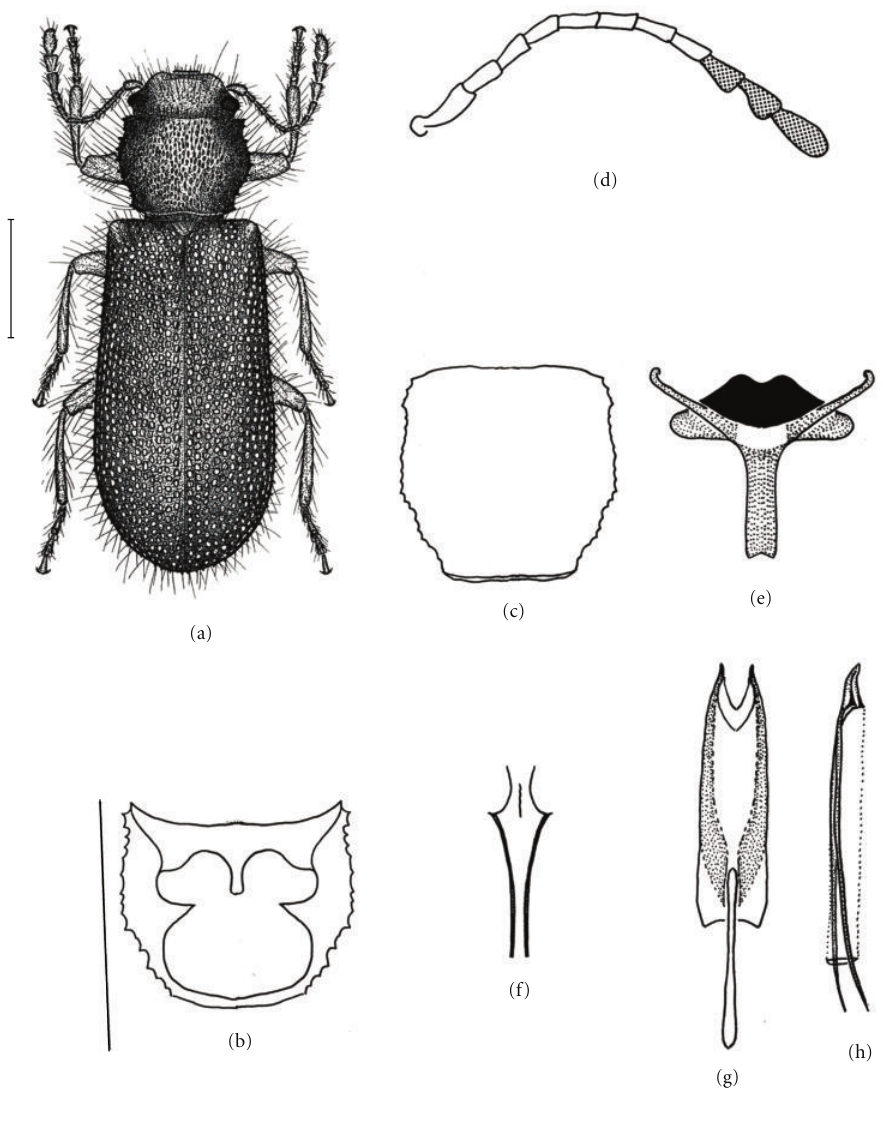
Figure 3: Various organs of Curacavi dentatus . (a) Habitus. (b, c) Thorax ((b) ventral, (c) dorsal). (d) Antenna. (e) Metendosternite. (f) Spiculum. (g) Tegmen. (h) Phallus.